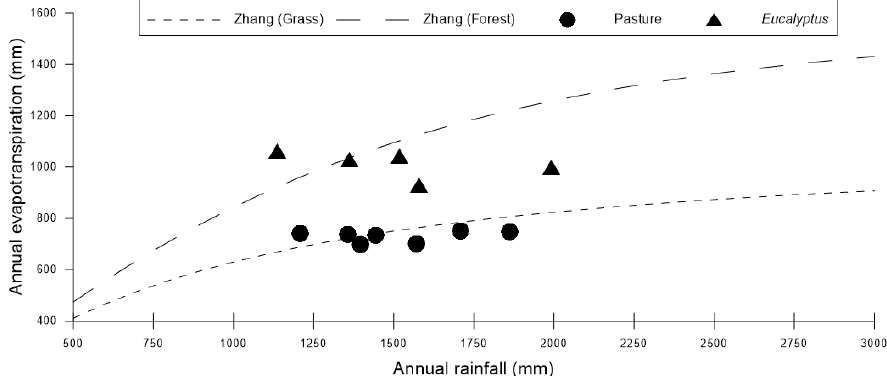
Figure 8. Annual evapotranspiration estimated for Eucalyptus plantation and pasture compared to the relationships presented by [51].